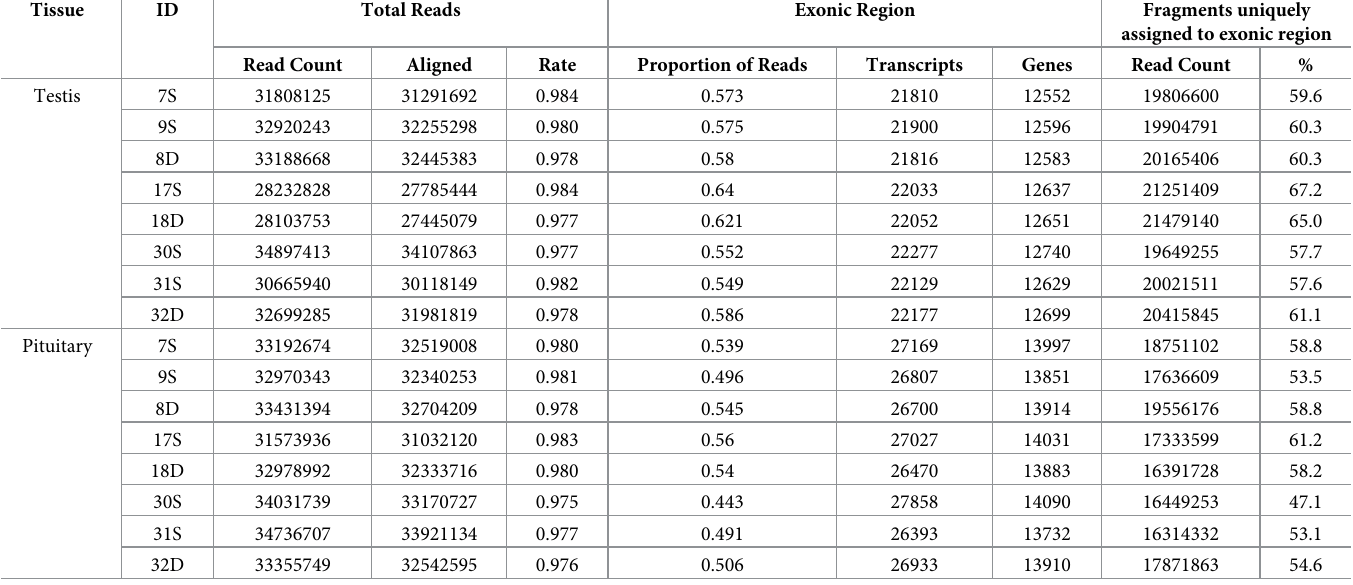
Table 5. RNA-Seq results and alignment statistics.